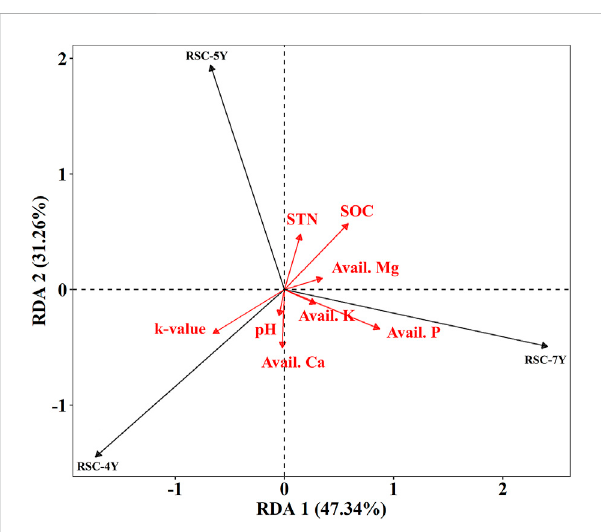
FIGURE 5 Redundancy analysis (RDA) of soil properties response variables and quantitative explanatory variables under rotational shifting cultivation for three fallow fi